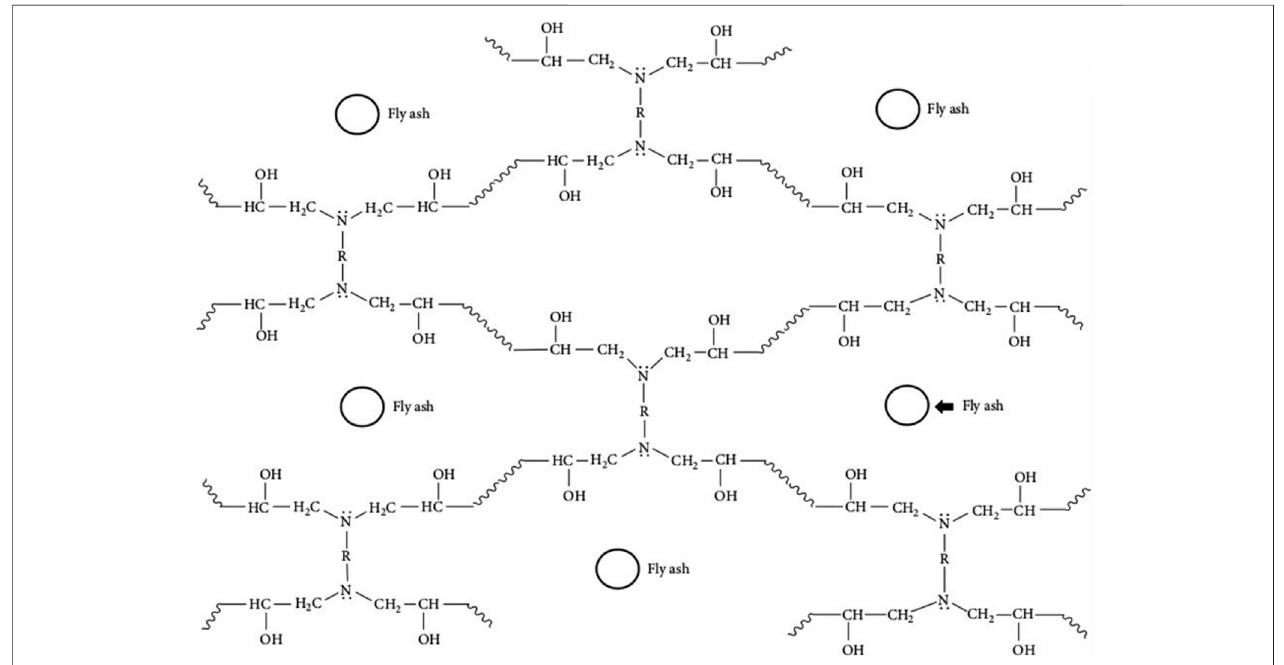
FIGURE 3 | Schematic diagram of fl y ash – containing epoxy networks after curing (Nguyen, 2020).